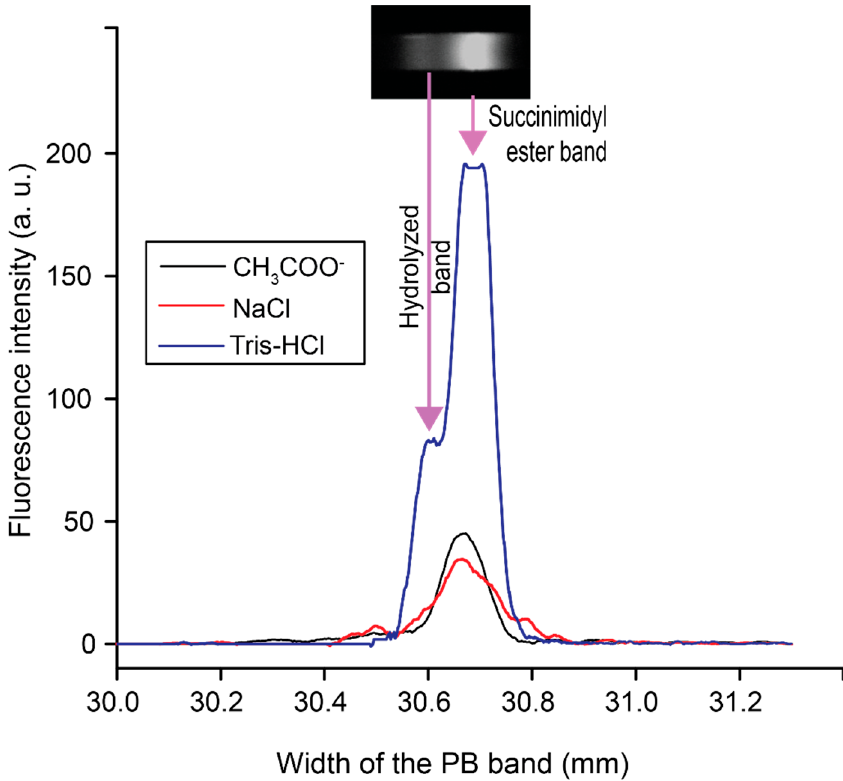
Figure 2. Selection of the leading electrolyte (LE) by evaluating the e ffi ciencies of preconcentration and separation of 100 pM PB. In total, 100 mM of three di ff erent types of LE at pH 8 (sodium acetate, sodium chloride, and Tris-HCl) were used to preconcentrate PB, while 40 mM of borate bu ff er at pH 9 was used as the TE under 123 V / cm. The intensity profiles of the PB band that formed at 30 mm downstream from the sample inlet is shown. The inset image illustrates the formation of two bands of PB due to hydrolysis.